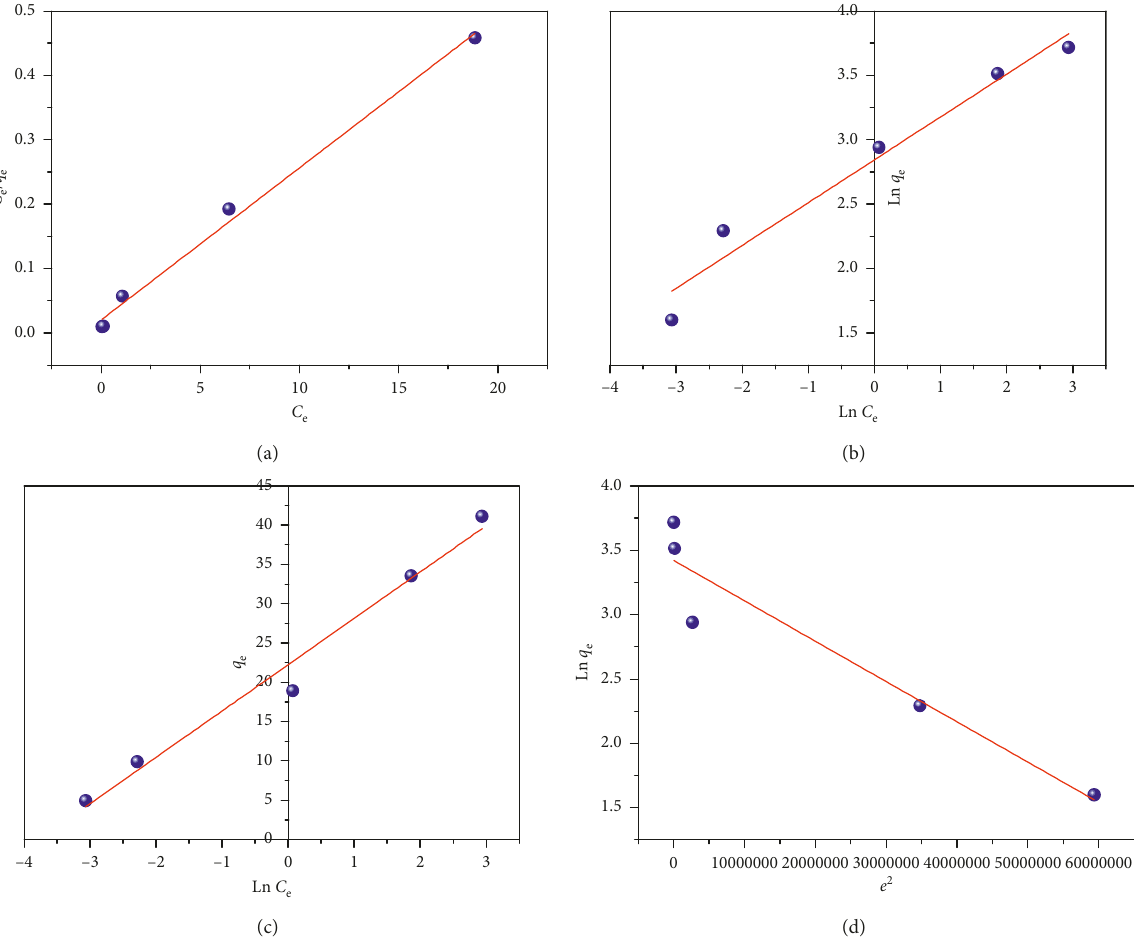
Figure 10: Langmuir (a), Freundlich (b), Temkin (c), and Dubinin–Radushkevich (d) isotherms for adsorption of MB by geopolymer. Table 7: Models isotherm constants for adsorption of MB using adsorbent. Langmuir